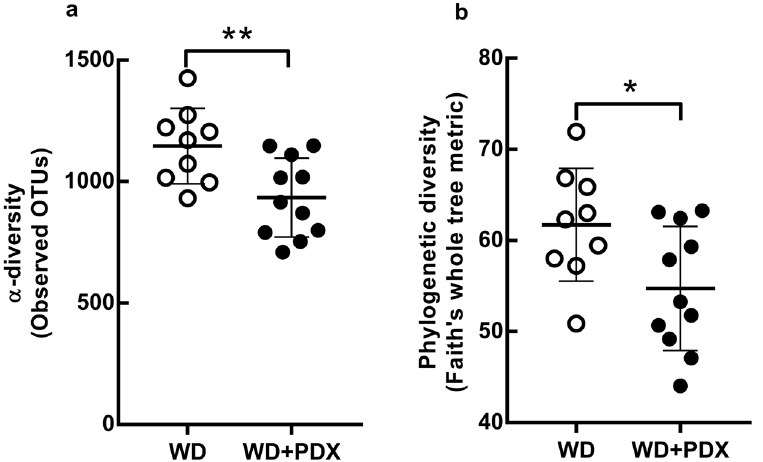
Figure 3. Alpha diversity metrics; ( a ) observed OTUs and ( b ) phylogenetic diversity for caecal microbiota in WD and WD + PDX mice. The values are presented as mean ± SD. * p ≤ 0.05, ** p ≤ 0.01; non-parametric t-test using 1000 Monte Carlo permutations.